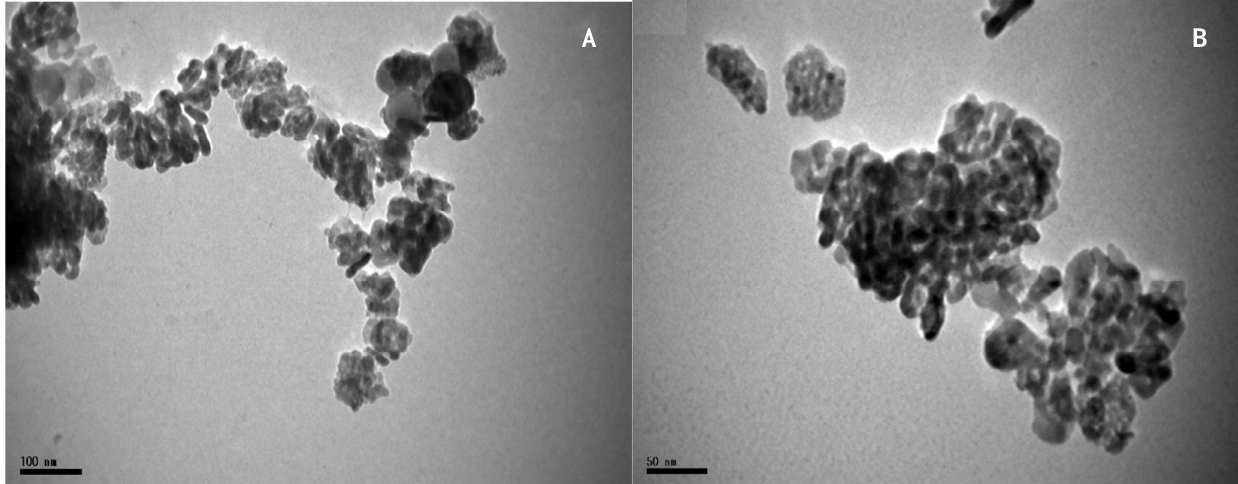
Figure 1. Transmission electron micrographs of dry titanium dioxide nanoparticles (nTiO aqueous suspension of nTiO